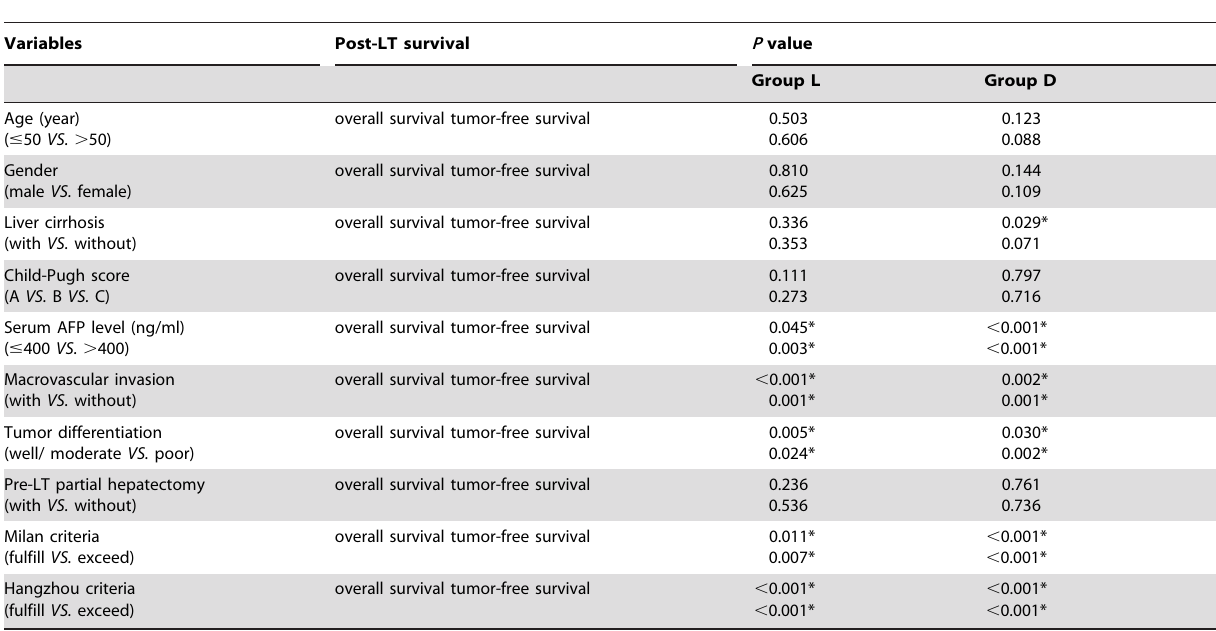
Table 2. Univariate analysis of variables related to post-LT survival (log rank test).